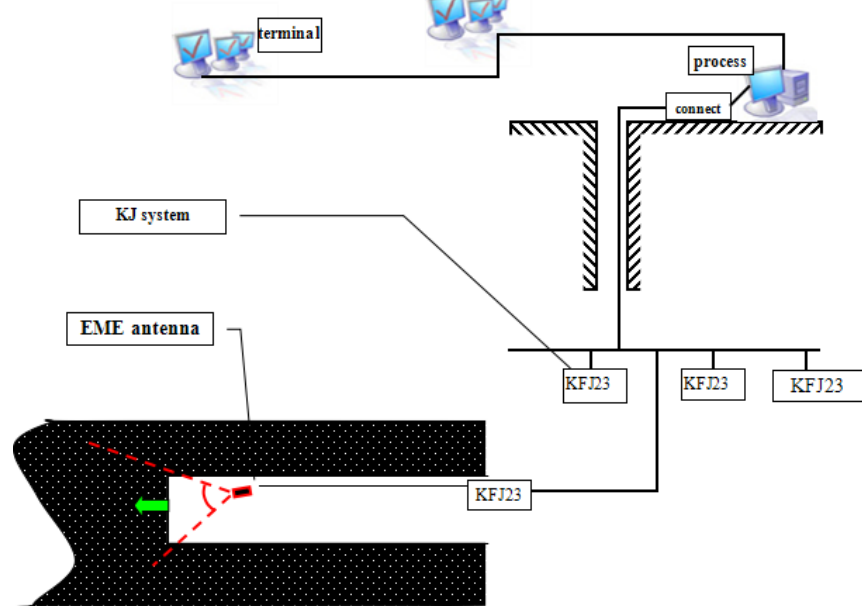
Figure 3. Instrumentation arrangement of the KBD7 EMR (Electromagnetic radiation Emission) monitor